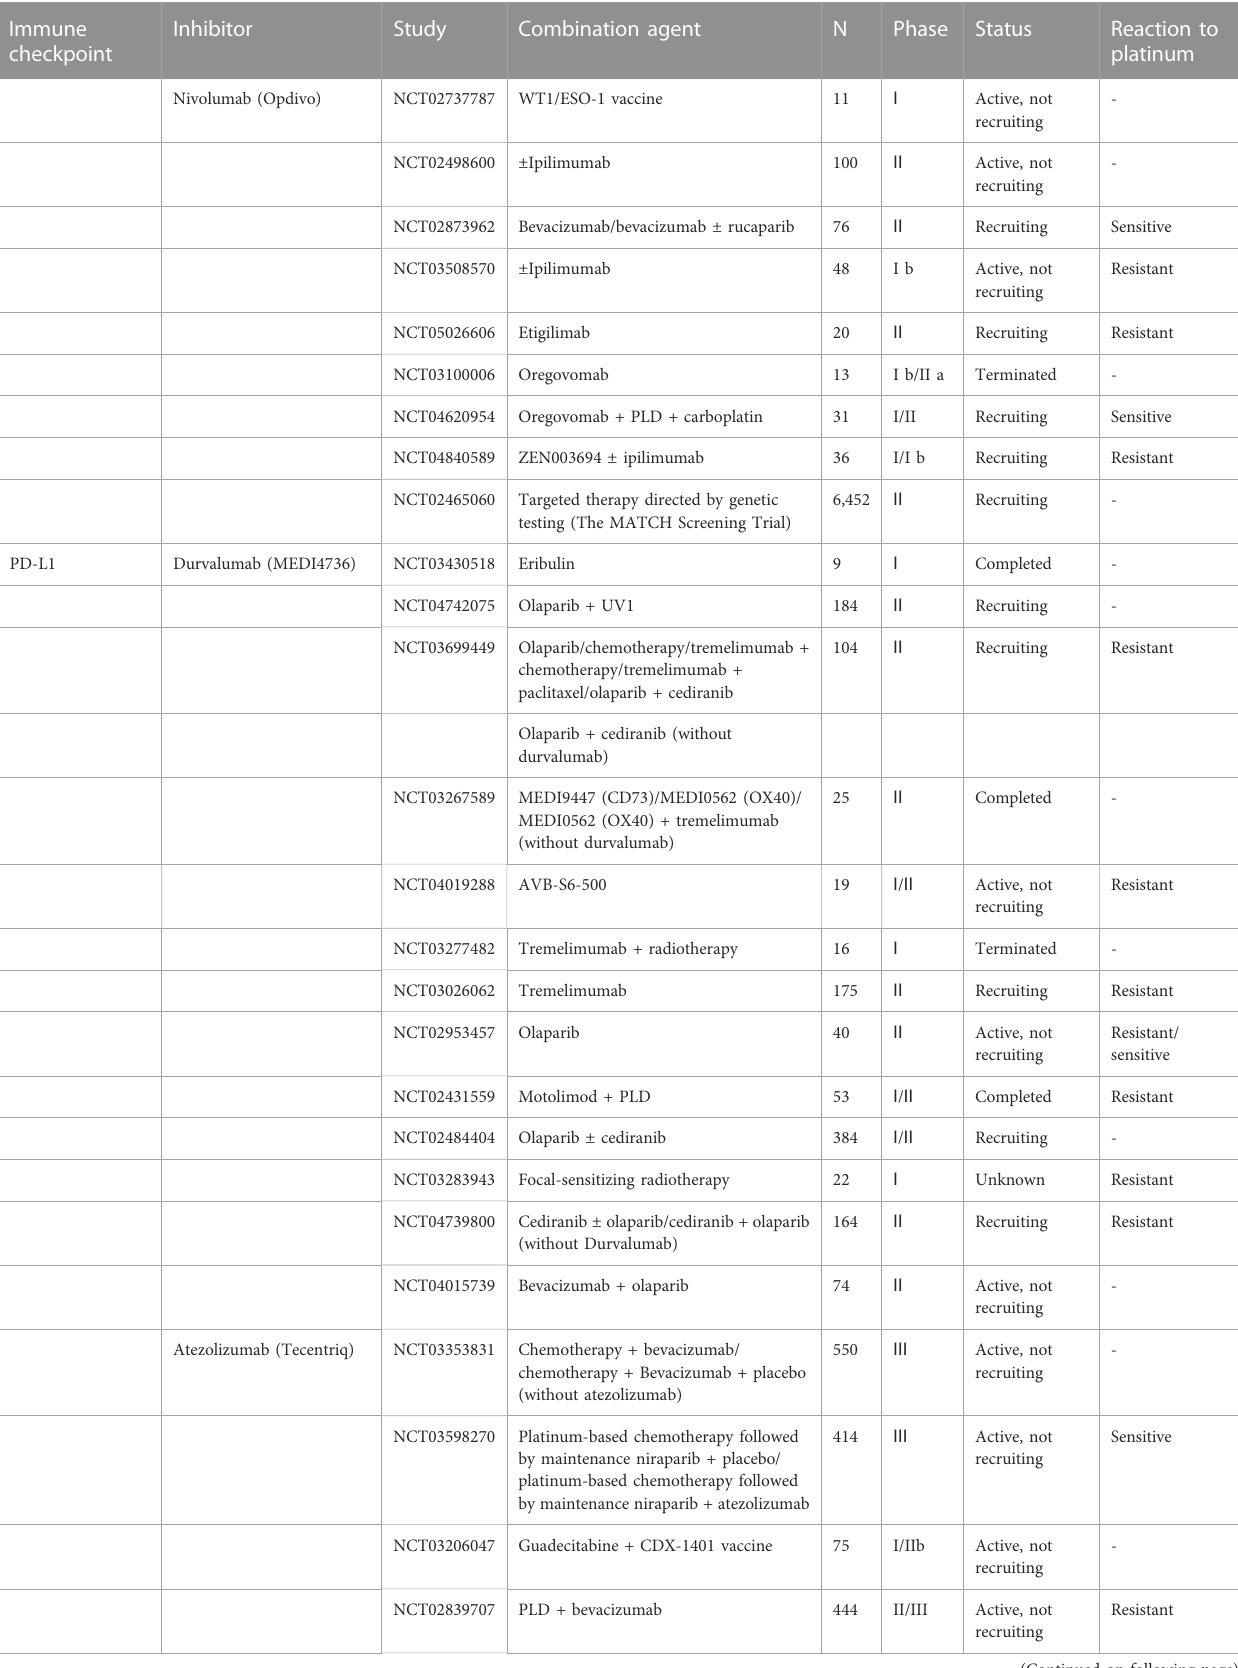
TABLE 3 ( Continued ) Summary of all clinical trials of immune checkpoint inhibitors in the treatment of recurrent ovarian cancer published in Clinical Trials.gov. Immune